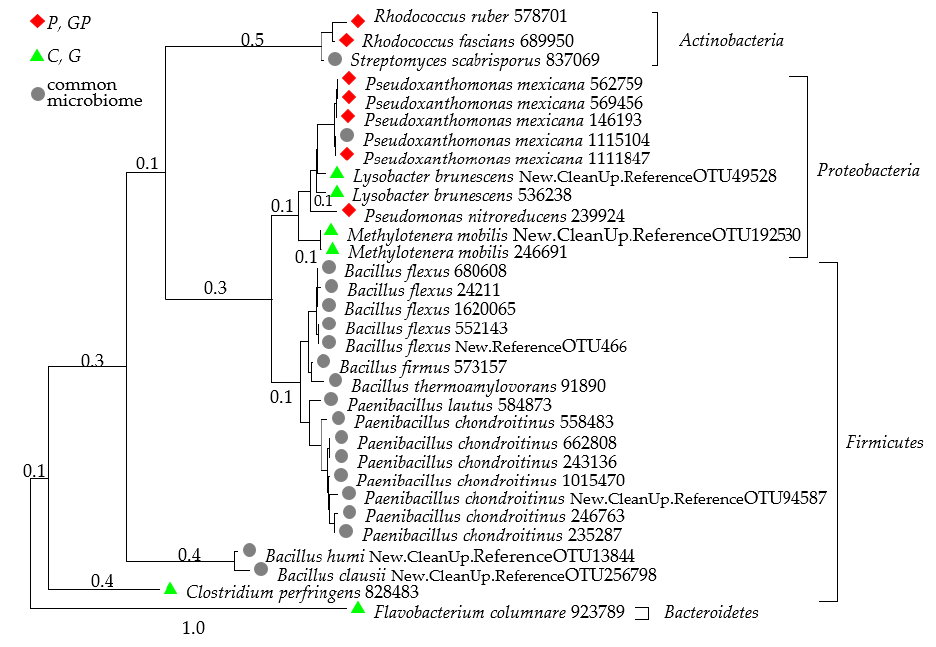
Figure 6. Phylogenetic tree of unique and common bacterial species. C—non-polluted and non-sown soil, G—non-polluted